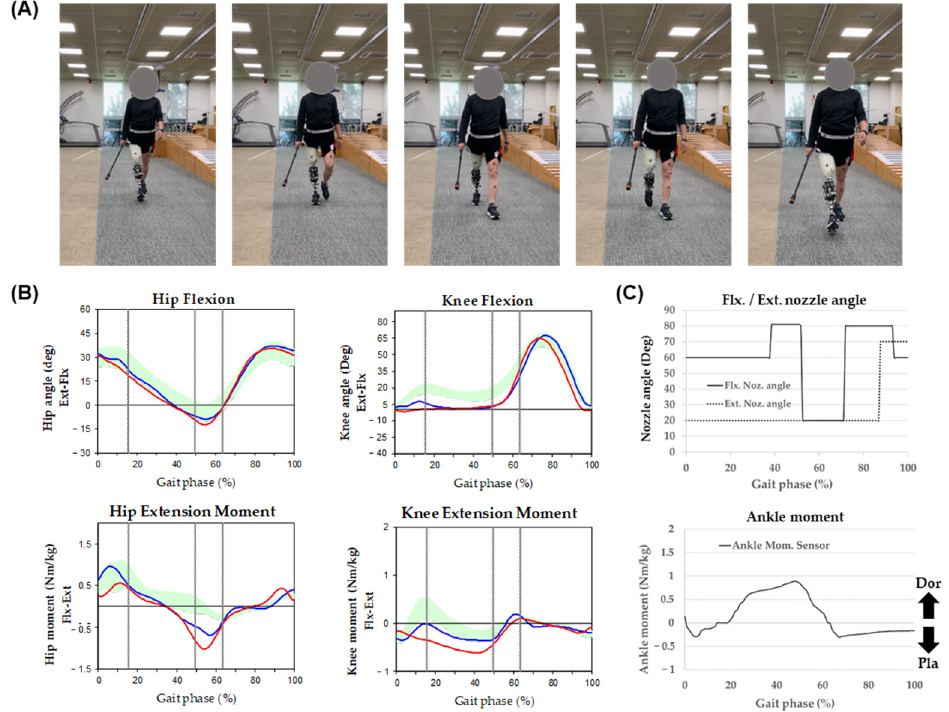
Figure 12. Gait analysis in passive mode, ( A ) Snapshots of the amputee’s frontal view during walking, ( B ) The knee and hip joint kinematics of our prosthesis during level ground walking using a three-dimensional motion analysis system, ( C ) Quantitative plots of hydraulic valve angle and ankle moment mounted on the prosthesis during level ground walking.